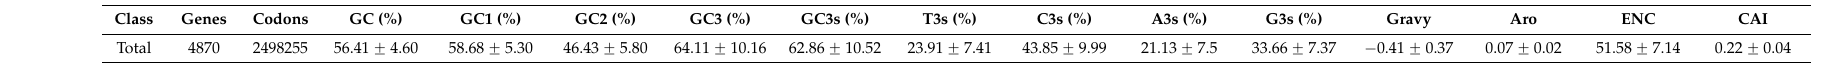
Table 1. Base composition, ENC, Gravy, and Aromo of codons from Epichloë